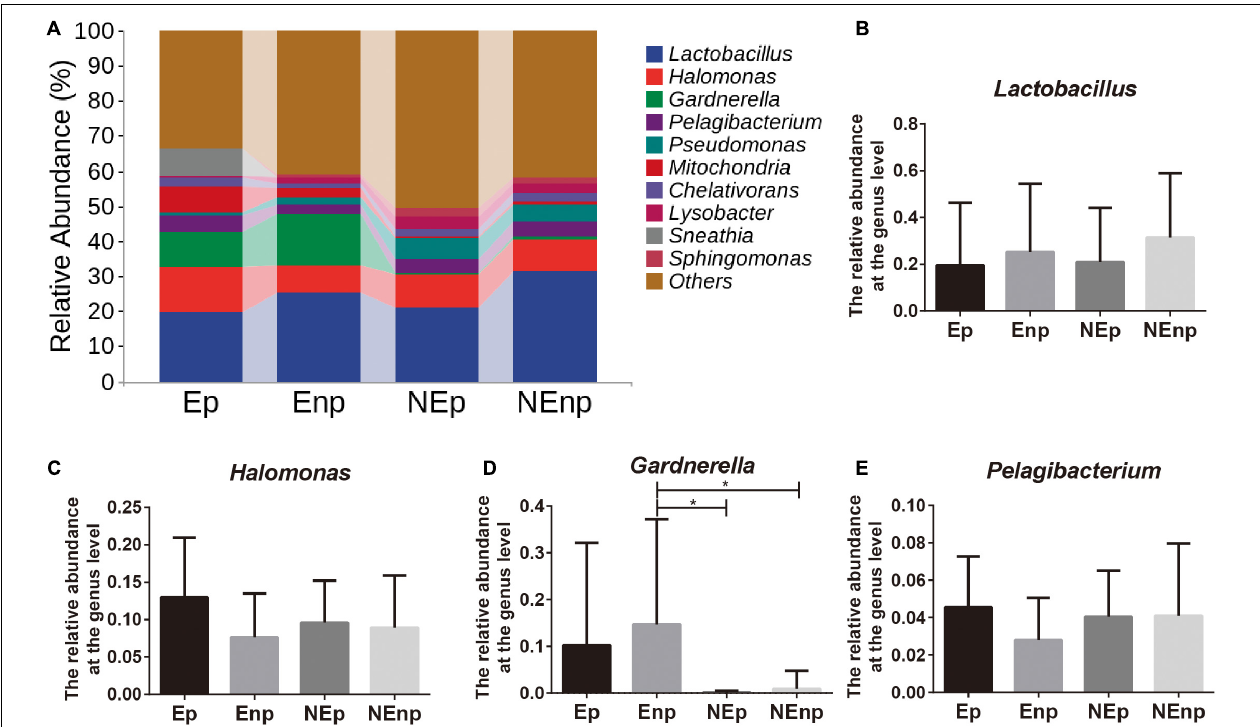
FIGURE 5 | Relative abundance of uterine microbiota at the genus level. (A) The relative abundances of the top 10 genera bacteria at the phylum level. The relative abundances of (B) Lactobacillus , (C) Halomonas , (D) Gardnerella , and (E) Pelagibacterium . Values are expressed as mean ± SD. * q <